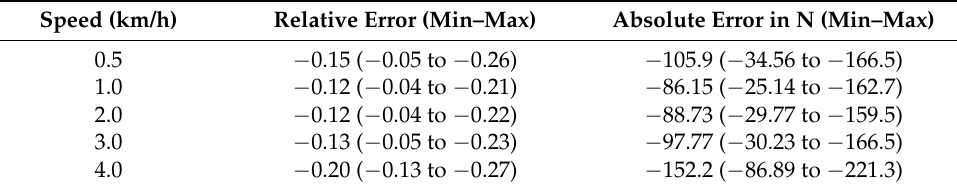
Table 1. Average relative and absolute error in peak loads (n = 10).